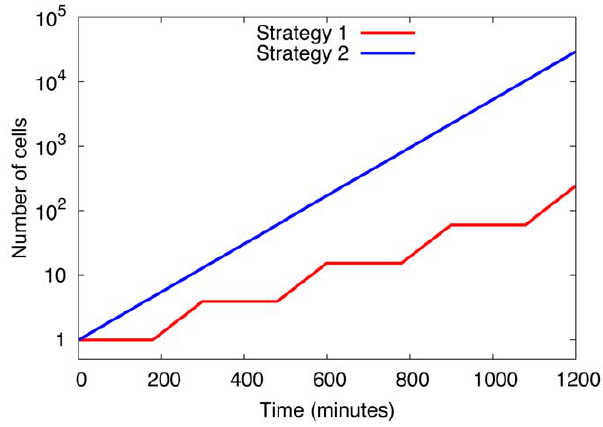
Figure 2. Growth curves of homogeneous populations in a fluctuating environment. Time dependence of the number of cells belonging to a homogeneous strategy 1 population (red curve) and a homogeneous strategy 2 population (blue curve). Data shown are for a switching time T S ~ 300min , adaptation time T A ~ 180min , and doubling times T 1 ~ 60min and T 2 ~ 80min . In this example, strategy